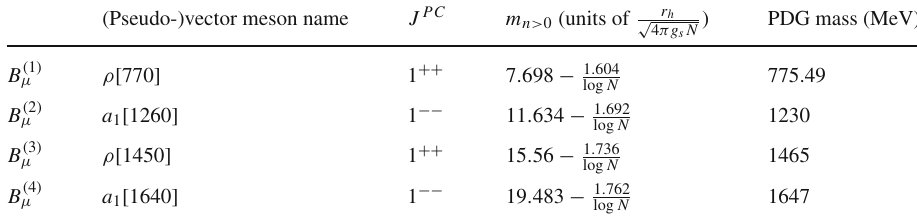
Table 2 (Pseudo-)vector meson masses from WKB quantization { 0 } applied to V (α n